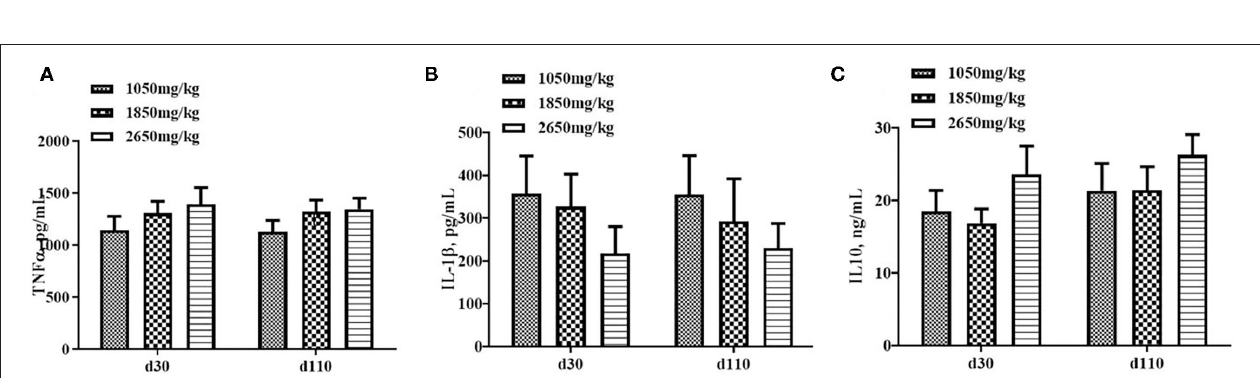
FIGURE 3 | Effect of dietary choline levels during gestation on the plasma concentrations of TNF α (A) IL-1 β , (B) IL10, and (C) at days 30 and 110 of gestation. Data are expressed as mean values with their standard errors, N = 8 for each treatment.